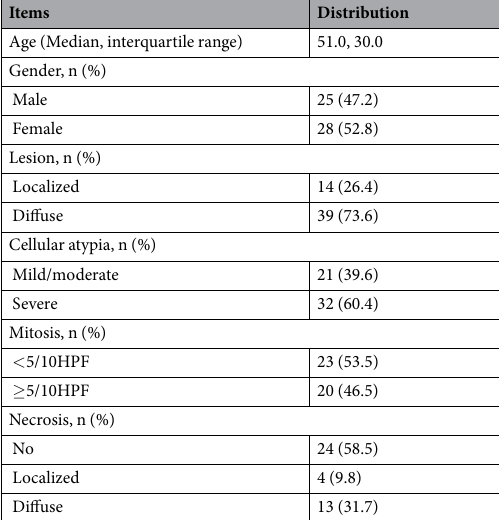
Figure 4. Electron microscopic sections presented the mutual interlaced long finger bumps and small amount of rough endoplasmic reticulum in cytoplasm. Items Distribution